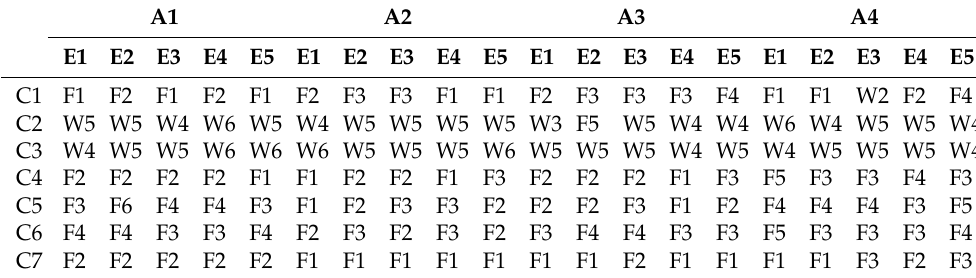
Figure 2. Hierarchical structure for 3PLP selection (source: authors’ compilation). Table 3. Summary table of decision makers’ evaluation grades.